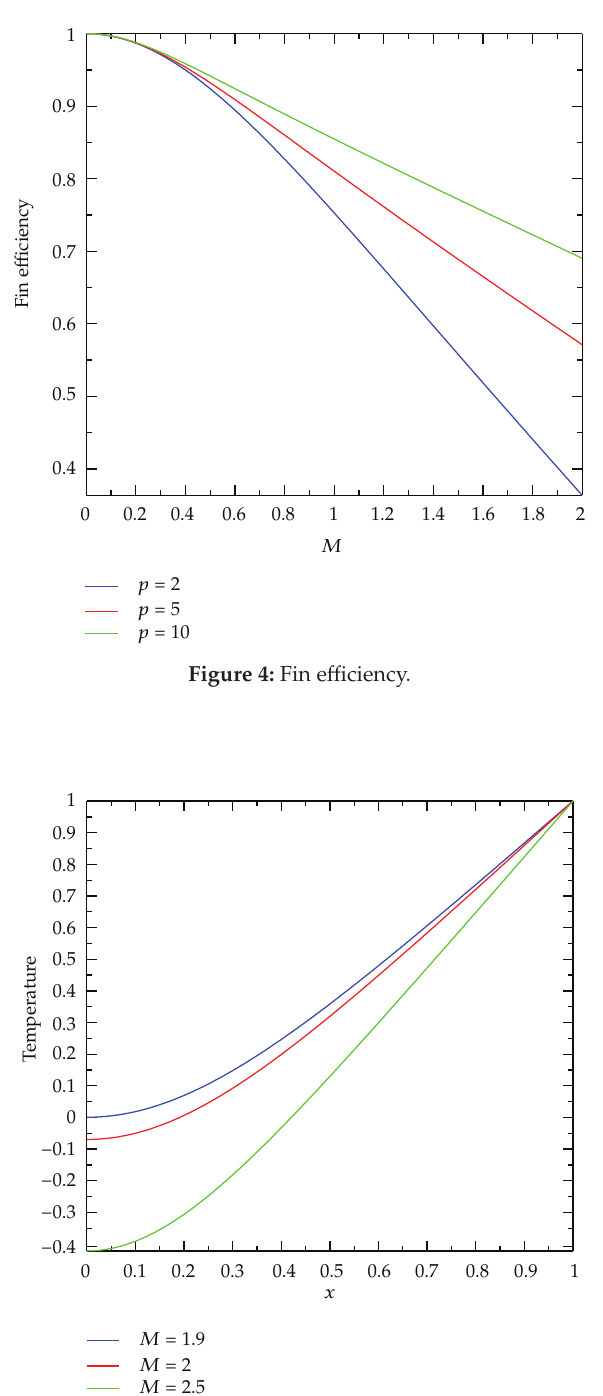
Figure 5: Temperature profile in a fin of varying values of the thermogeometric fin parameter. Here p is fixed at